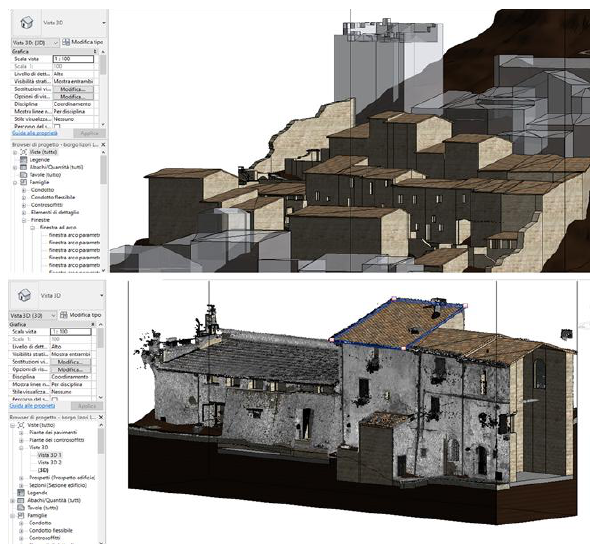
Figure 9. Revit, different LOD levels of the BIM model